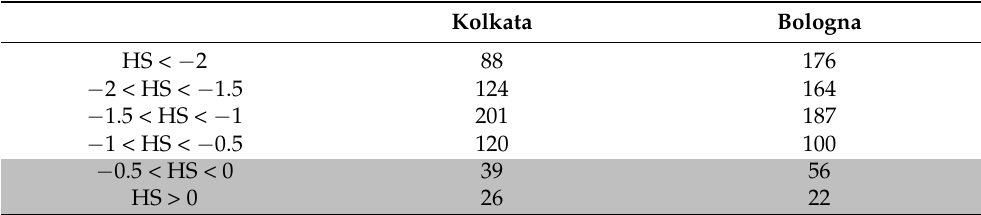
Figure 7. Distribution of HS values in natural rain of Bologna and Kolkata. Table 2. Number of DSD samples (2 min) in different HS classes. Cells in grey represent classes where break-up exists.